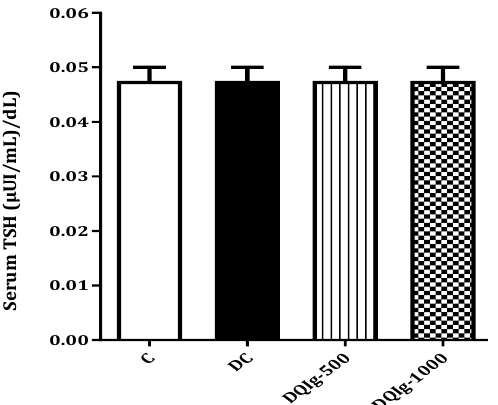
Figure 3. Effects of Quercus infectoria galls (QIg) extract on serum thyroid stimulating hormone (TSH) concentration in diabetic male Wistar rats. Data are shown as mean±SEM, n=4. C, negative control; DC, diabetic control; DQIg-500, diabetic rats treated with 500 mg/kg BW/day of QIg extract; DQIg-1000, diabetic rats treated with 1000 mg/kg BW/day of QIg extract